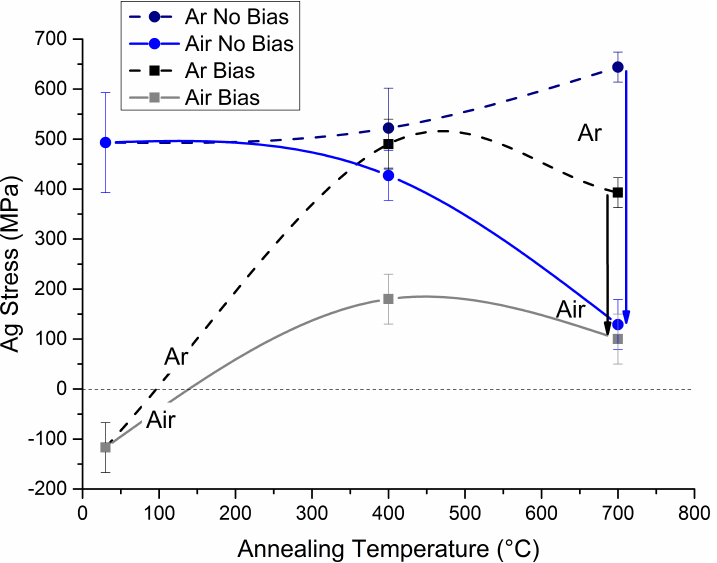
Figure 7. Ag in-plane stress results for the different annealing temperatures and atmospheres, measured ex-situ, at room temperature, for samples with and without